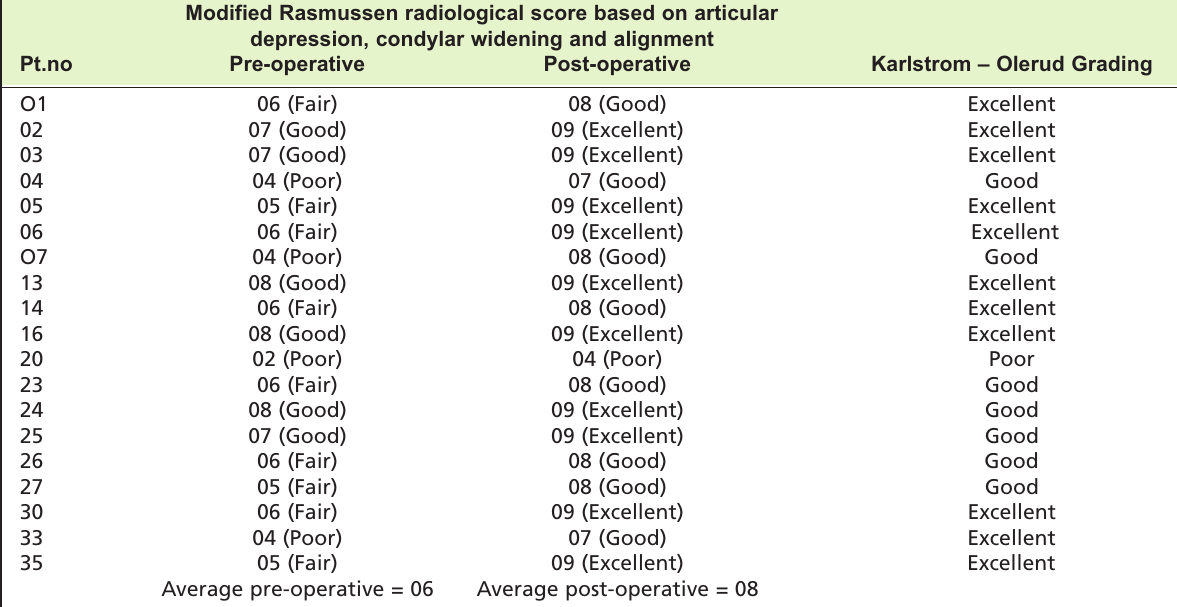
Radiological and functional scores of patients with type VI fractures Table V: Modified Rasmussen radiological score based on